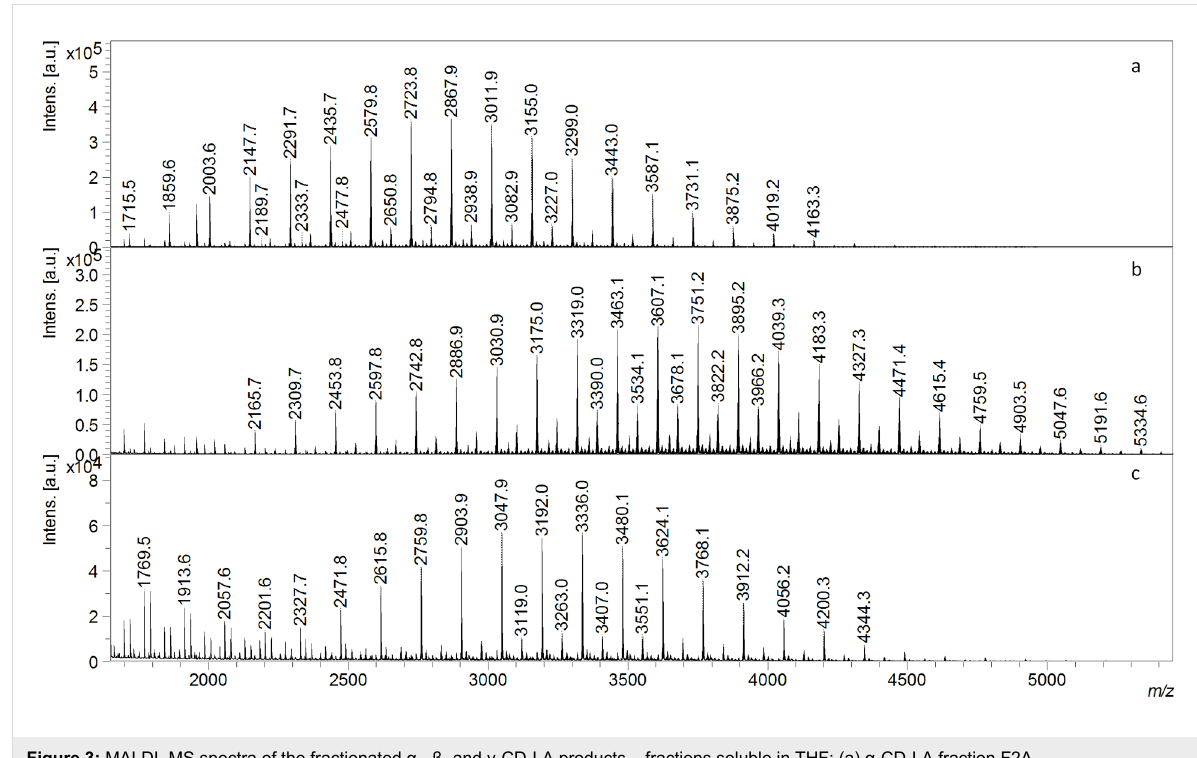
Figure 3: MALDI–MS spectra of the fractionated α -, β - and γ -CD-LA products – fractions soluble in THF: (a) α -CD-LA fraction F2A, (b) β -CD-LA fraction F2B and (c) γ -CD-LA fraction F2C.